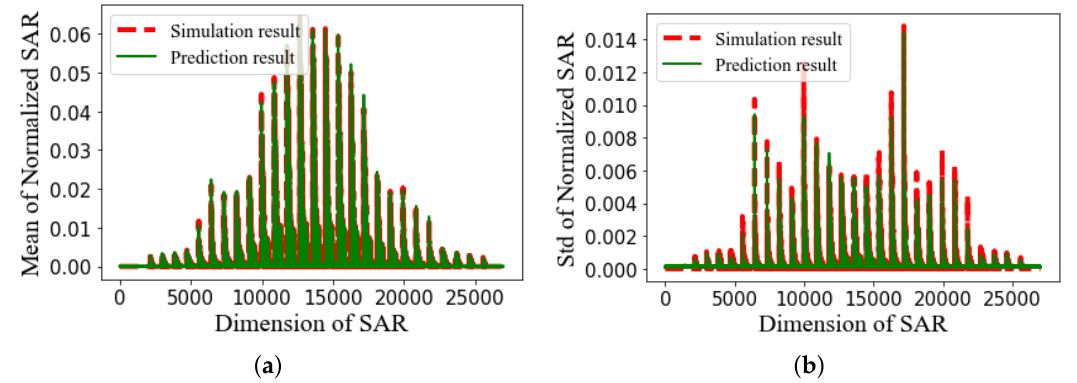
Figure 9. ( a ) Mean of the normalized SAR in brain, and ( b ) standard deviation of the normalized SAR in brain.